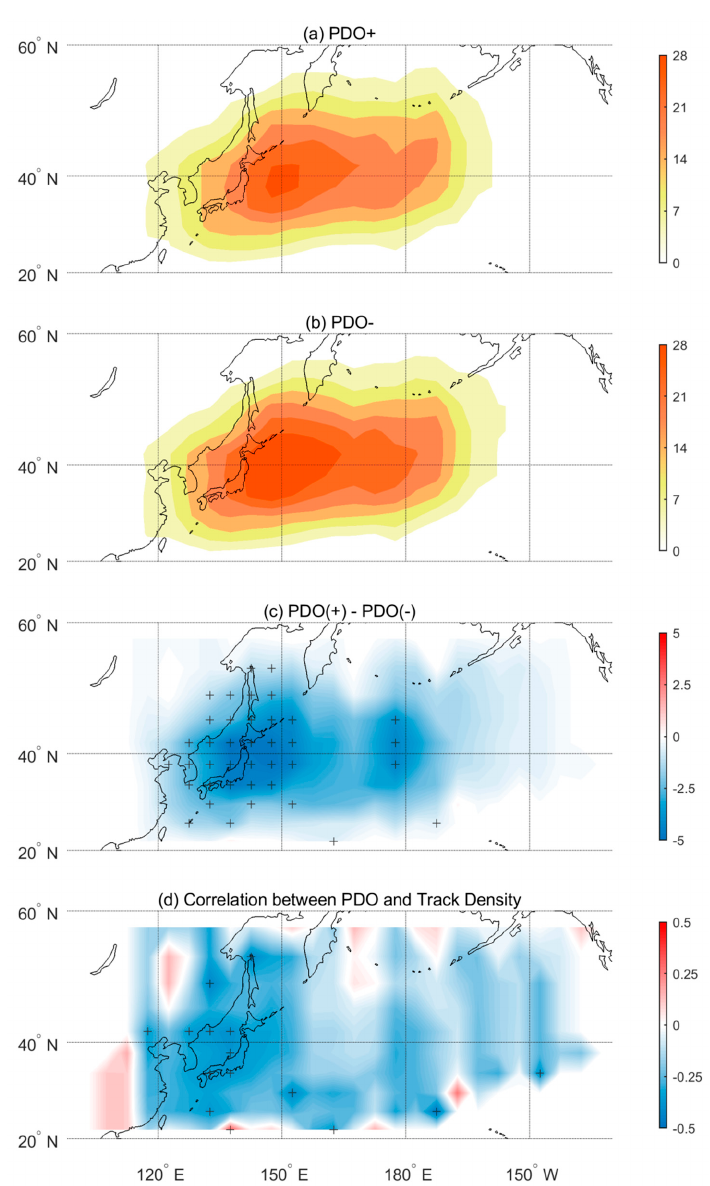
Figure 7. ( a , b ) Composite of the ETC track density in the positive and negative phases of PDO over the Northwest Pacific in wintertime from 1979 to 2018, Unit: cyclones per winter per grid. ( c ) The difference in ETC density between the positive and negative phases of PDO. ( d ) Correlations between the PDO index and ETC track density. Grids with values statistically significant at the 95% level are indicated by the symbol “+”.